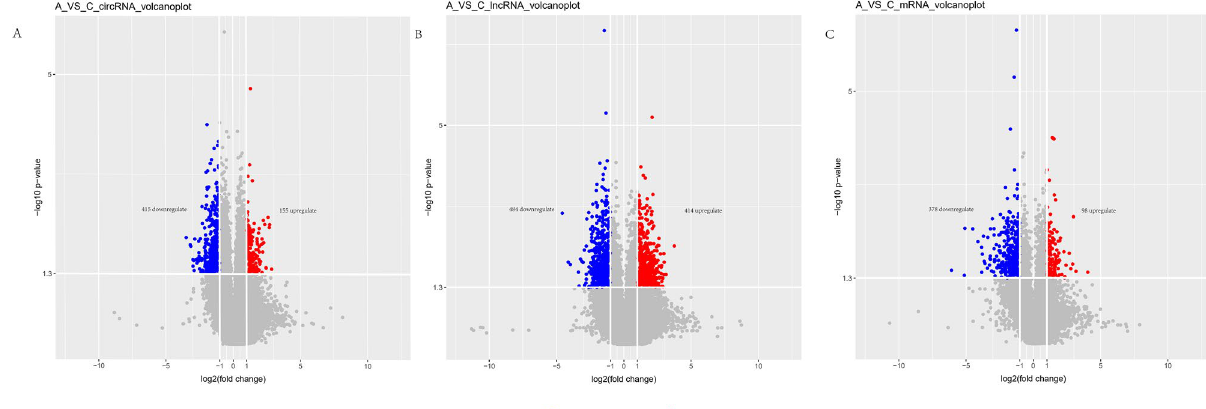
Figure 1. Volcano plots of different RNA types. ( A ) circRNA; ( B ) lncRNA; ( C ) mRNA; down- and up- regulations are marked with blue and red colors, respectively. Fold change (linear) ≥ 2, p value < 0.05. Samples are from 3 recurrent COVID-19 patients and 3 healthy